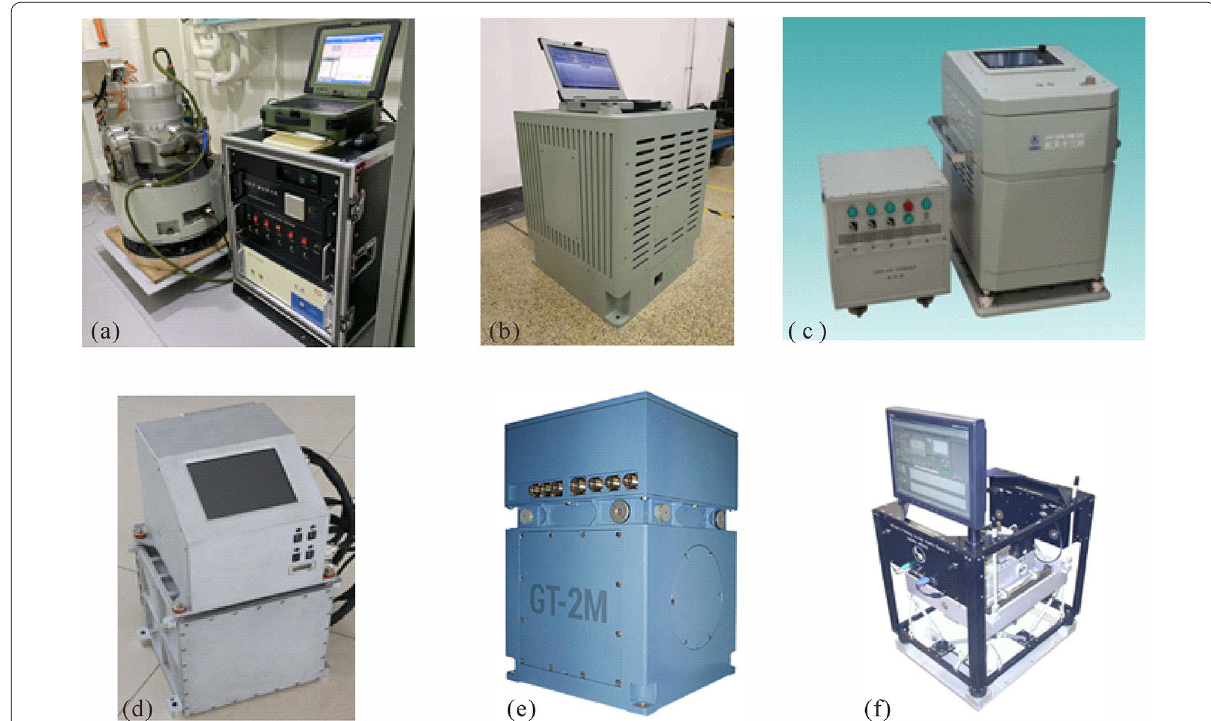
Fig. 1 Marine gravimeters: a CHZ-II; b ZL11; c SAG-2M; d SGA-WZ; e GT-2M; f